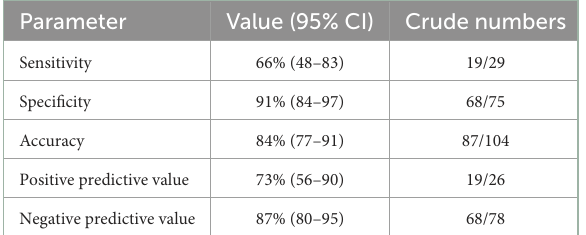
TABLE 2 Diagnostic performance of dynamic 3D MRA for the detection of intracranial arteriovenous shunts in patients with non-traumatic